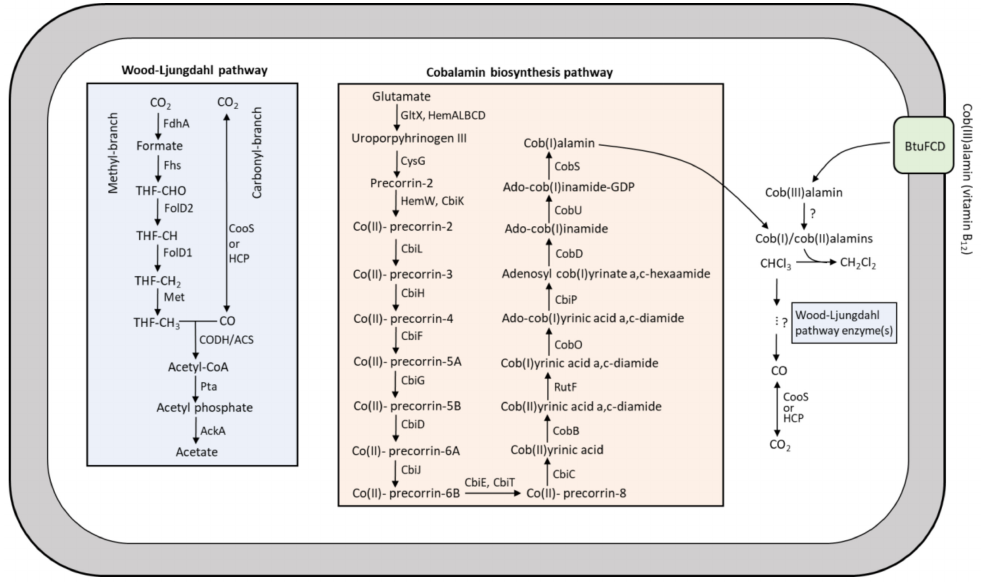
Figure 5. Proposed CF transformation pathway in Clostridiales presumably mediated by Wood-Ljungdahl pathway enzymes and cob(I) / cob(II)alamins, which are biosynthesized de novo or transported from the extracellular environment. The gene encoding CODH / ACS was not found in the metagenomes. Gene names and encoded proteins are shown in Supplementary Table